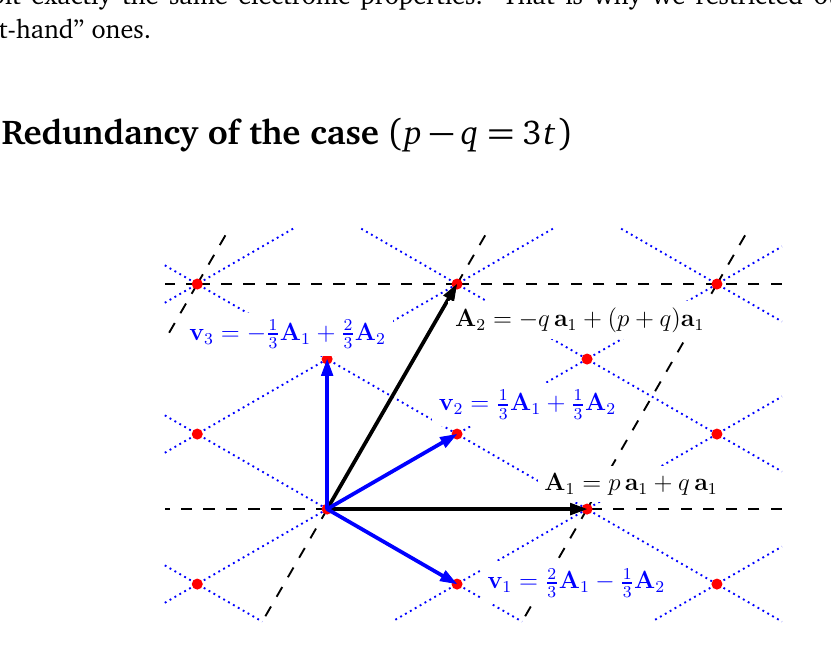
Figure 7: The upper layer asymmetric supercell ( p , q ) with p = q + 3 t . It is